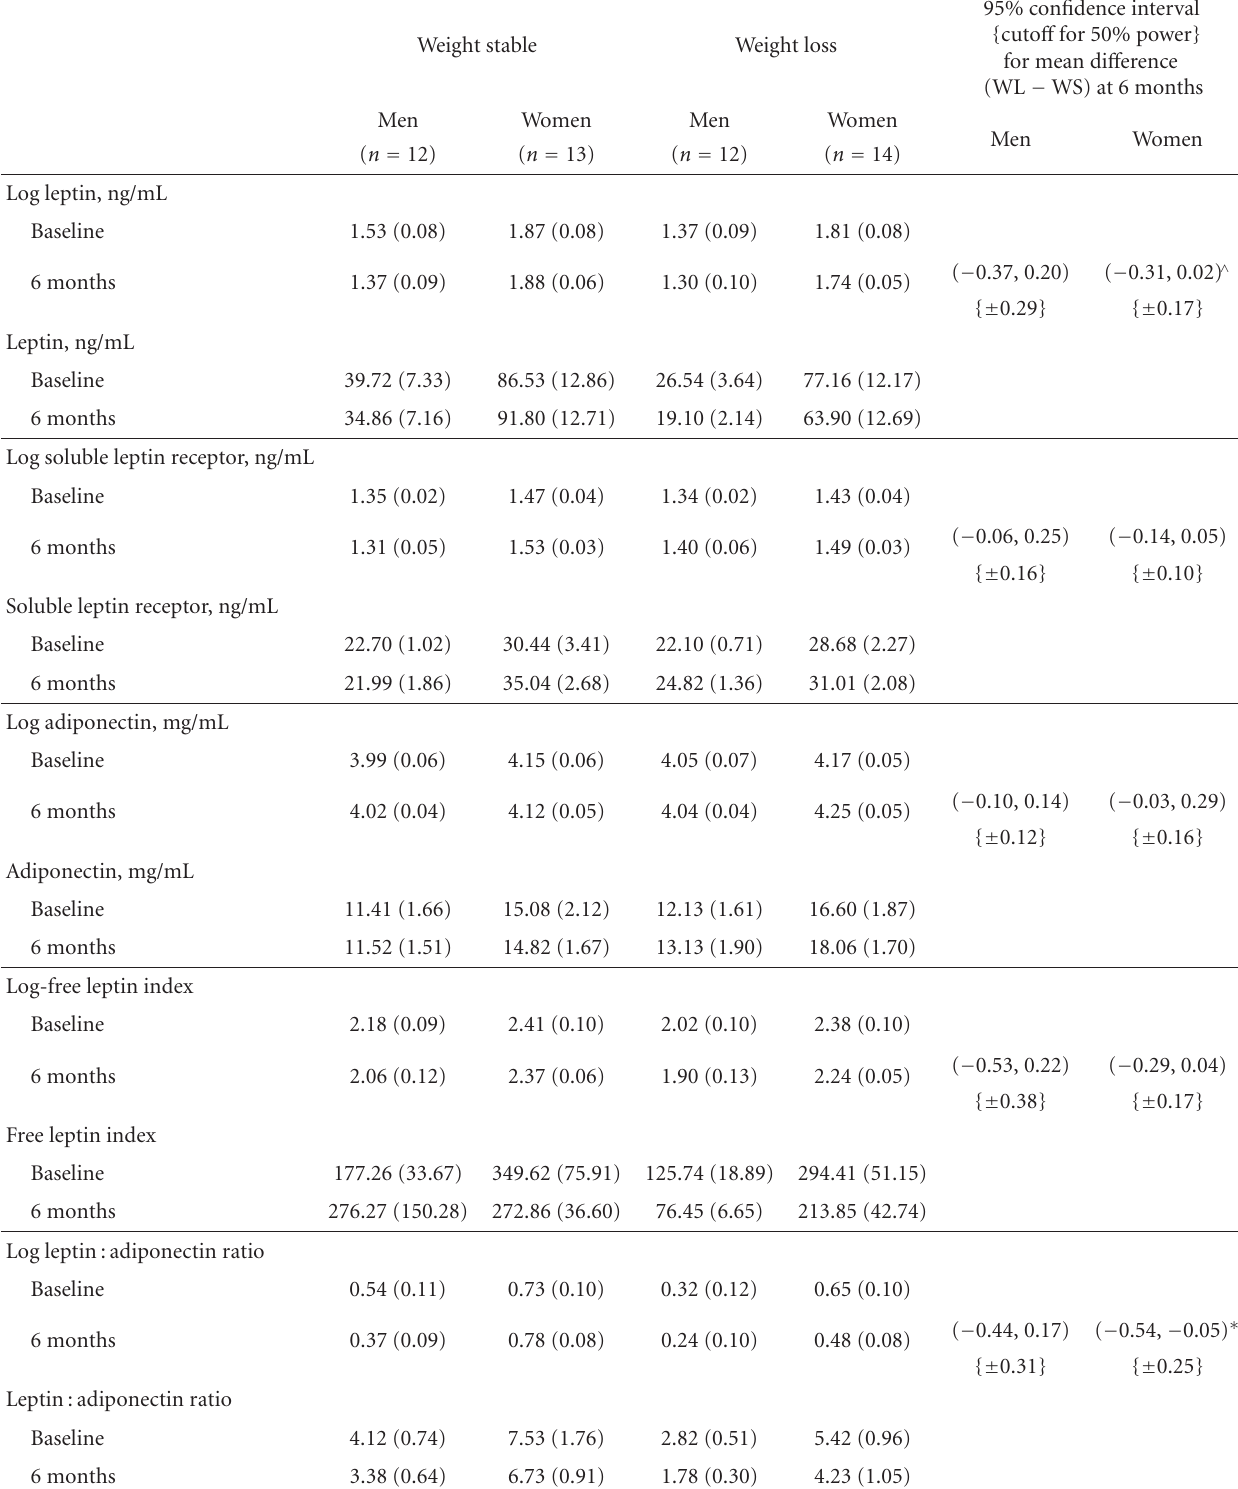
Table 3: Plasma concentrations of adipokines at baseline and 6 months. Statistical analysis was performed on 6 months log values. These means are estimated marginal means (SEM). Nontransformed values are presented for ease of